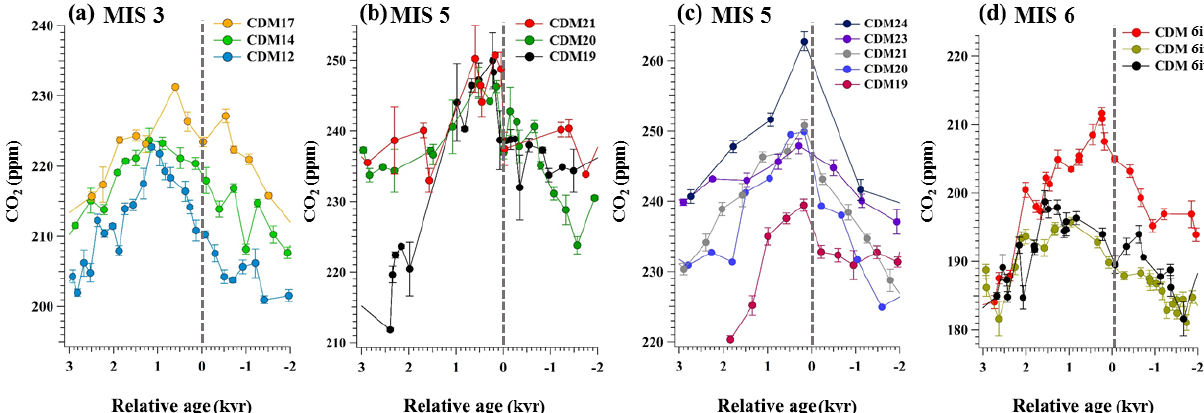
Figure 8. CDM lags relative to abrupt temperature increases in the NH. Dotted grey lines indicate when climate changes abruptly in the NH as indicated by the CH 4 jumps. During the last glacial period, the AIM number corresponds to the DO number for corresponding DO and AIM events, and for MIS6 numbers correspond to event numbers. (a) Atmospheric CO 2 as measured using the TALDICE ice core during MIS 3, (b) atmospheric CO 2 as measured using the Byrd ice core during MIS 5, (c) atmospheric CO 2 as measured using EDML ice core during MIS 5, (d) new CO 2 composite as derived in this study for MIS 6. For MIS 6, we selected the 3 CDM that correspond to an abrupt methane increase; the other CDM do not correspond to an abrupt change that fulfill our 50ppb detection criterion (see main text for details). Note that the scale of the y axis is not the same for the four